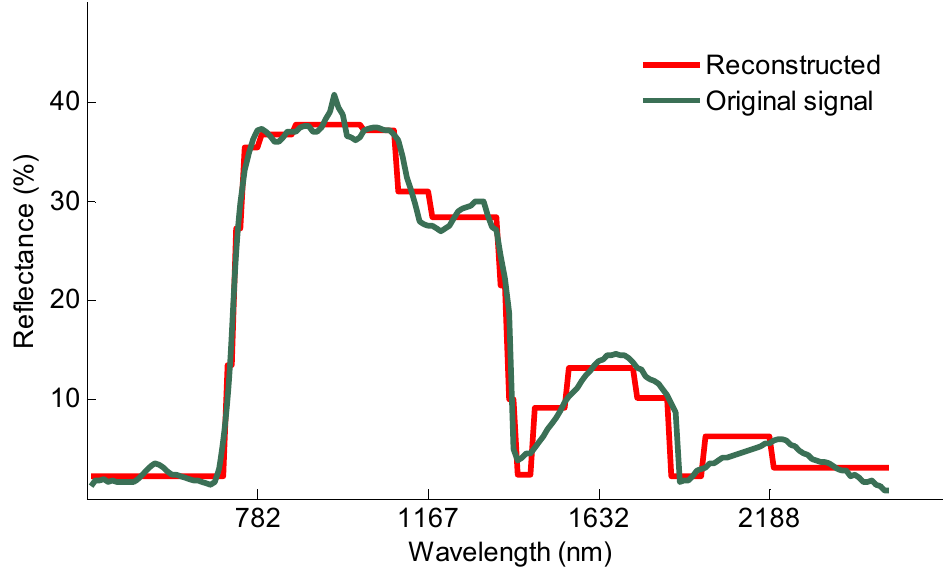
Figure 5. Reconstructed (with Haar coefficients having cumulative 99.0% energy) versus original signal for one of the plots.